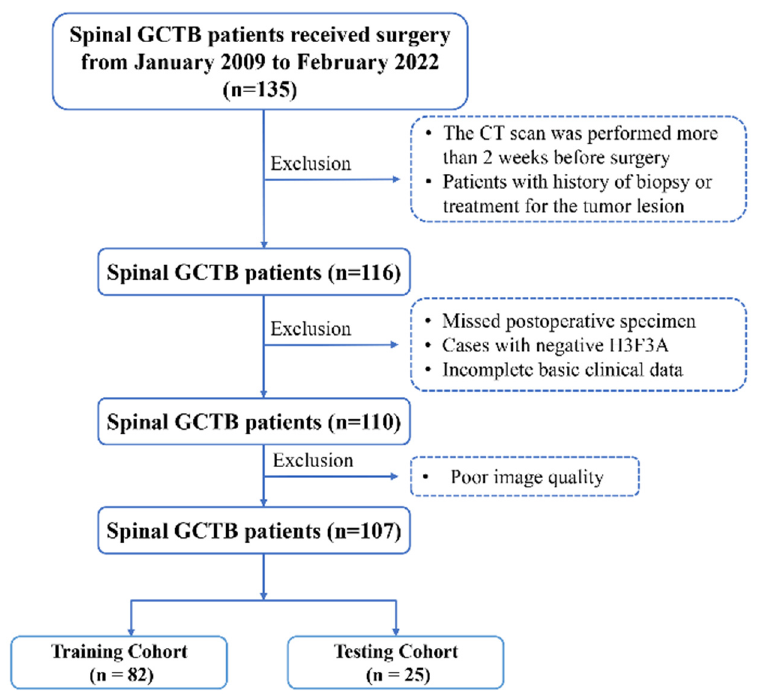
Figure 1. Study flow chart of patient selection. GCTB, giant cell tumor of bone; H3F3A, H3 histone family 3A.